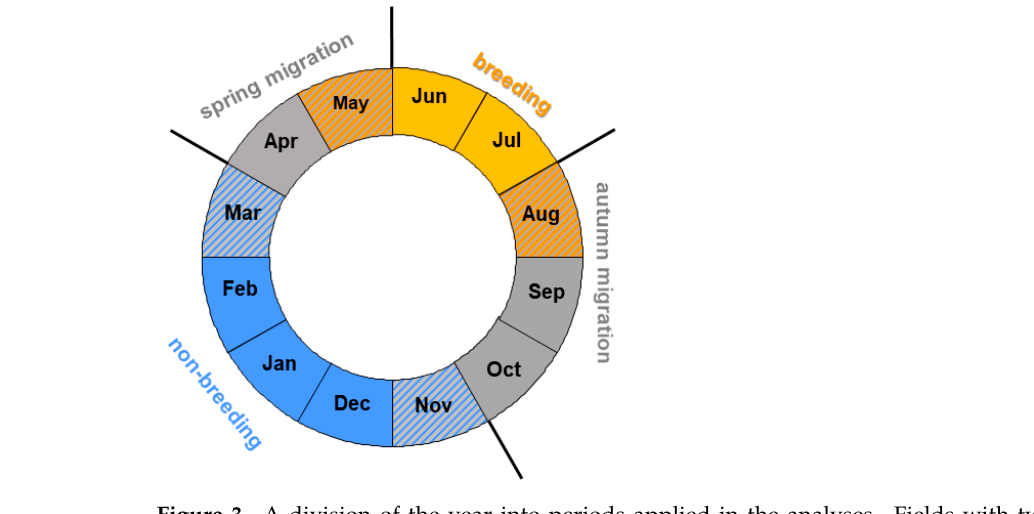
Figure 3. A division of the year into periods applied in the analyses. Fields with two colours indicate possible overlapping of subsequent life stages for different populations of a species of a long-distance migrant.